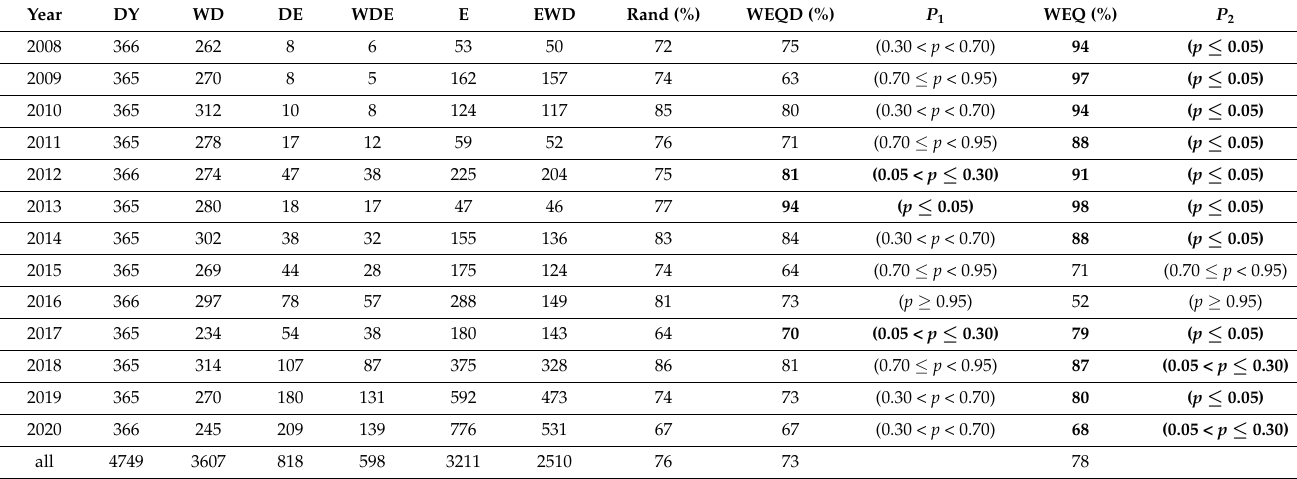
Table 4. Scenario #4, rain threshold R = 0.1 mm, memory τ = 2 day. The cases 0 < P ≤ 0.30 are highlighted in